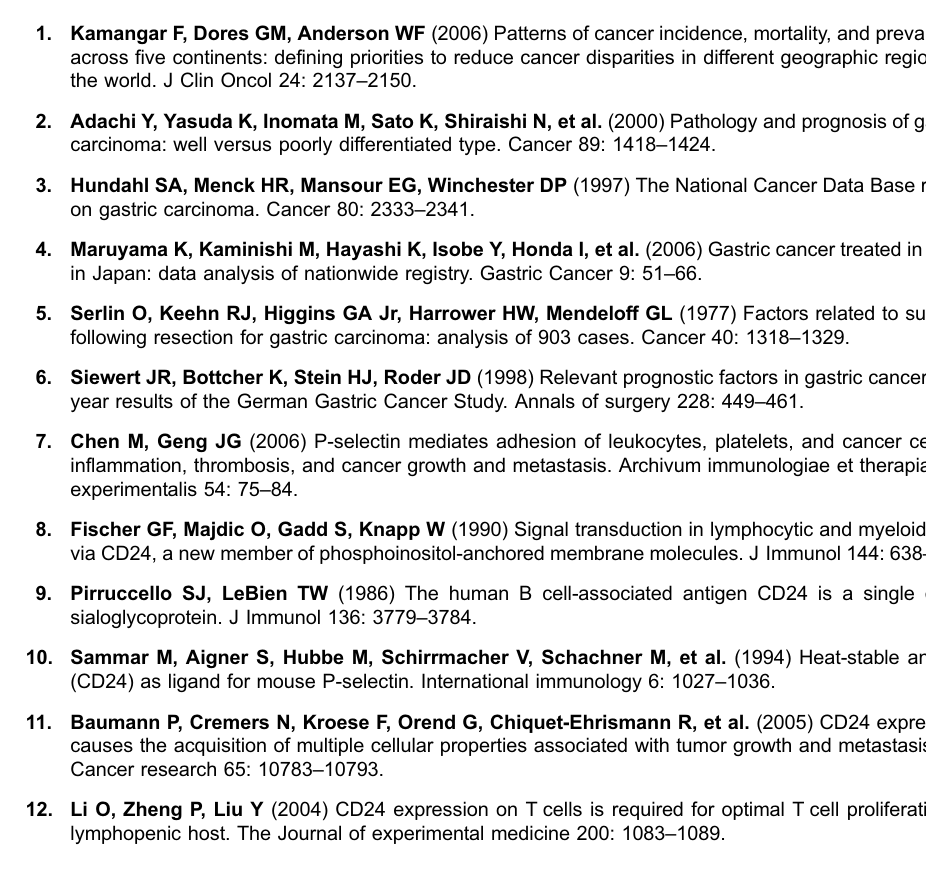
S1 Table. Excluded studies and the reasons for